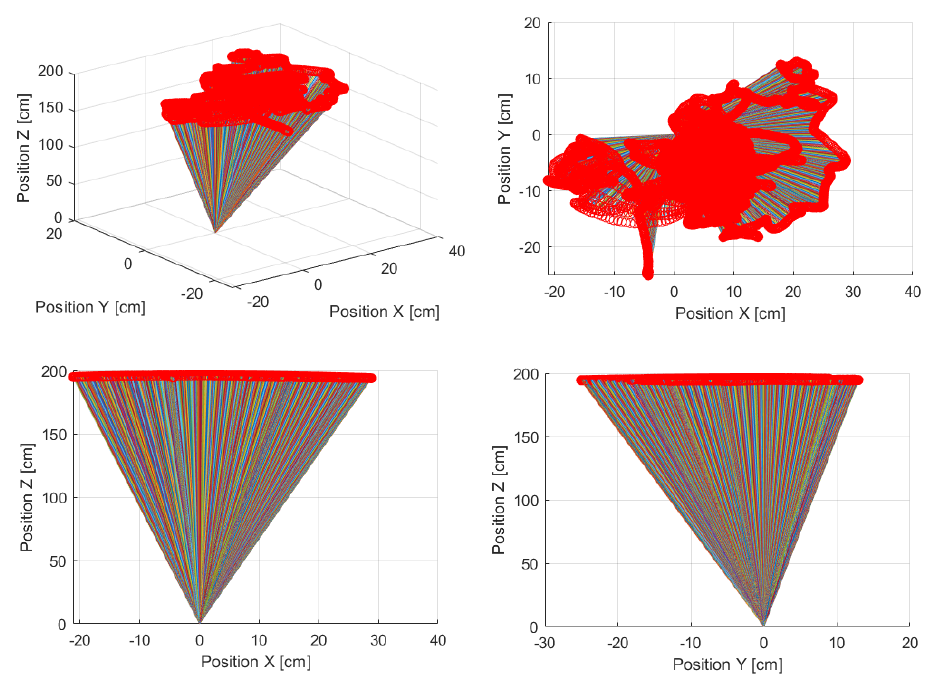
Figure 8. A change of the base vector orientation in the global XYZ -coordinate system [Source: MovieBird